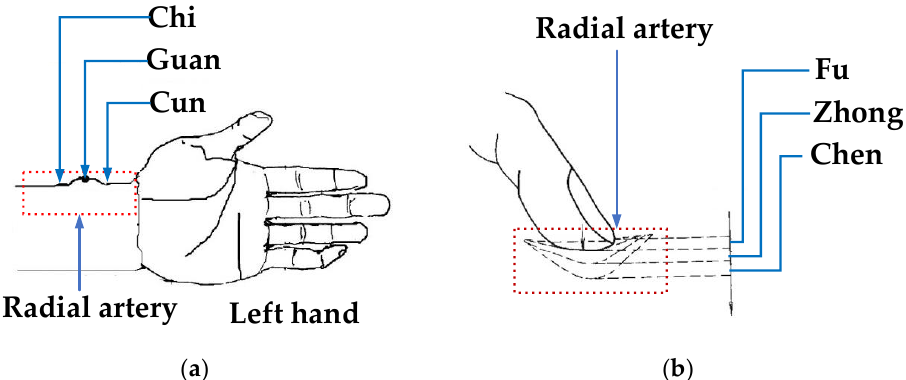
Figure 1. ( a ) Schematic diagram of the test locations of Cun, Guan, and Chi; ( b ) Diagram of different static pressure tests.